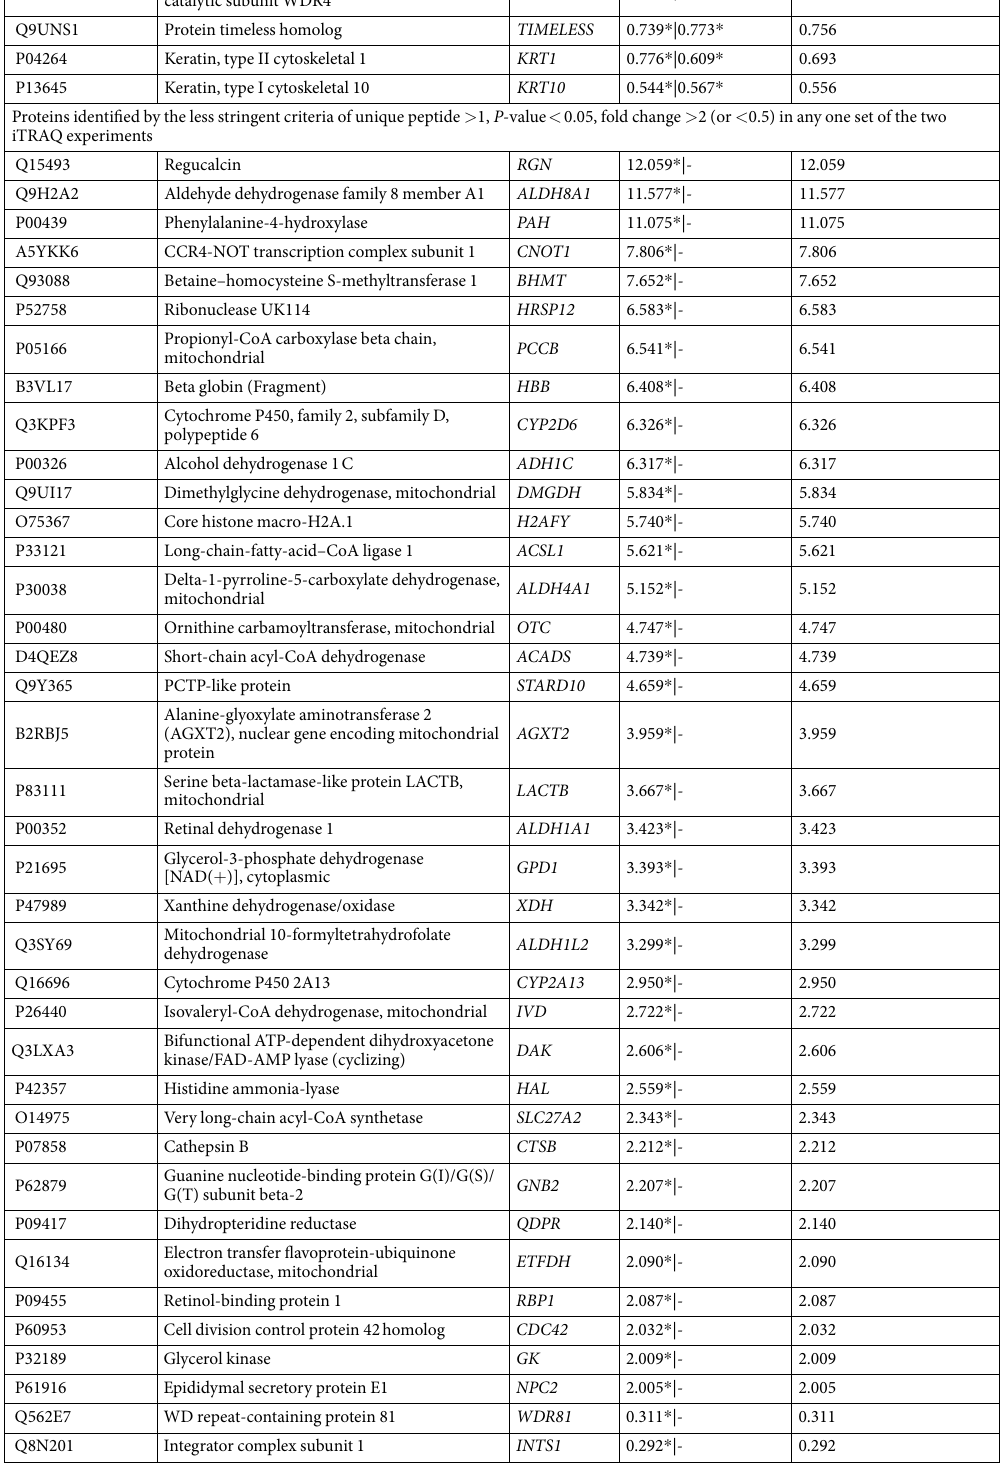
Table 1. All the differentially expressed proteins identified by the iTRAQ experiments. * P <